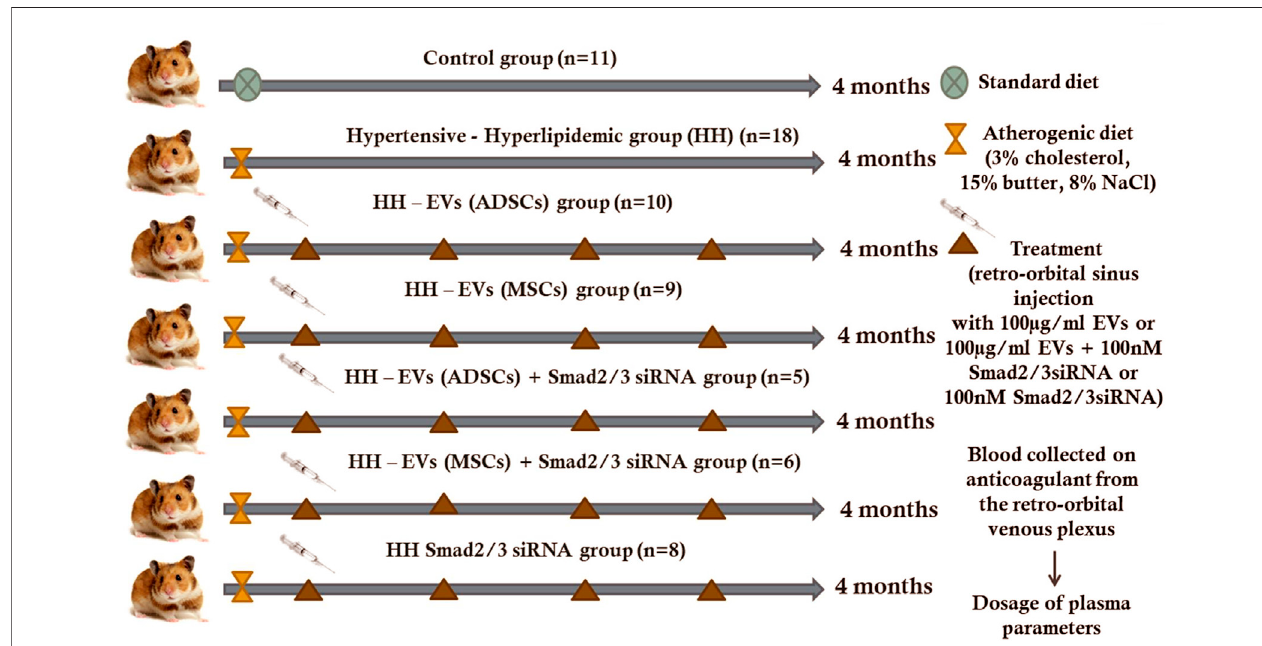
FIGURE1| Schematicrepresentationofexperimentalanimalmodelsobtainedforaperiodof4months. GoldenSyrianhamsters(67malesand3monthsold)were divided into seven experimental groups: (1) control (C group) ; (2) simultaneously hypertensive – hyperlipidemic (HH group) ; (3,4) HH hamsters with retro-orbital sinus injection containing 100 μ g/ml EVs from both ADSCs and BM-MSCs ( HH-EVs (ADSCs) group and HH-EVs (MSCs) group )) ; (5,6) HH hamsters with retro-orbital sinusinjectioncontaining100 μ g/mlEVs(fromADSCsorBM-MSCs)transfectedwith100 nMSmad2/3siRNA (HH-EVs(ADSCs)+Smad2/3siRNAgroupandHH- EVs (MSCs)+ Smad2/3 siRNA group) ; (7) HH hamsters with subcutaneous injection containing 100 nM Smad2/3 siRNA (HH-Smad2/3 siRNA group) . The HH group was obtained by combining the atherogenic and high-salt